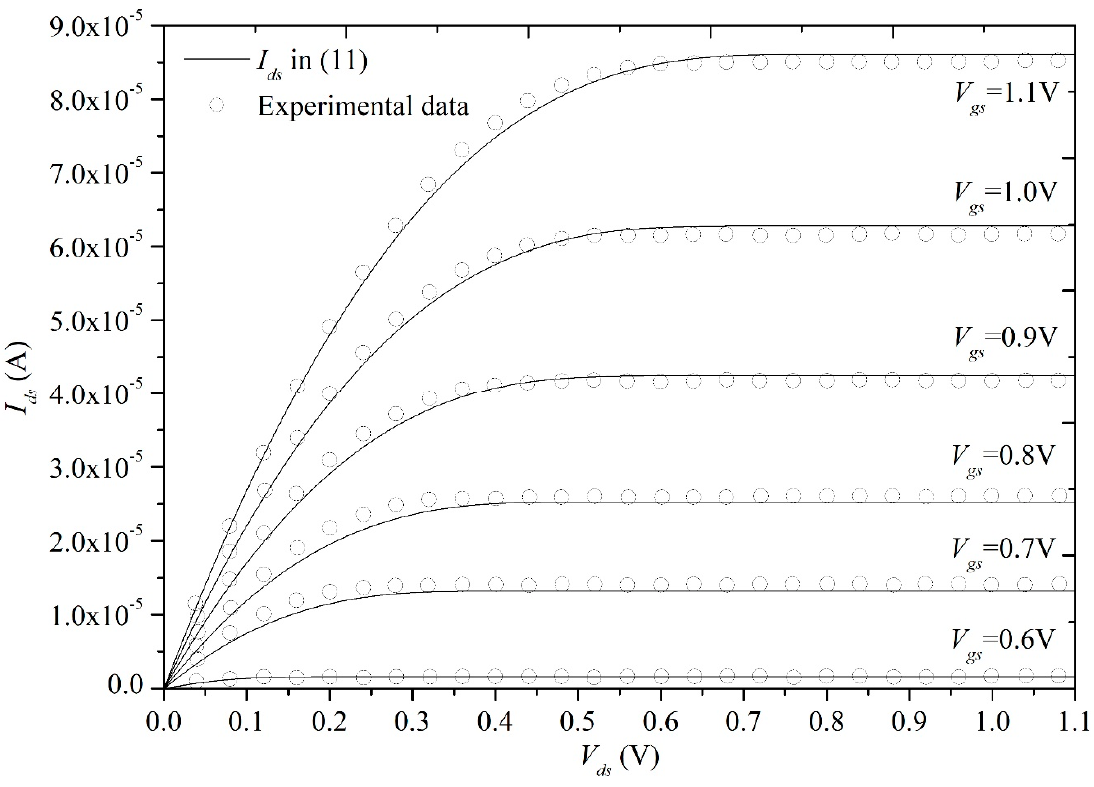
Figure 7. Comparisons of transfer characteristics between our drain current model results and long-channel experimental data [22] from Khandelwal et al.